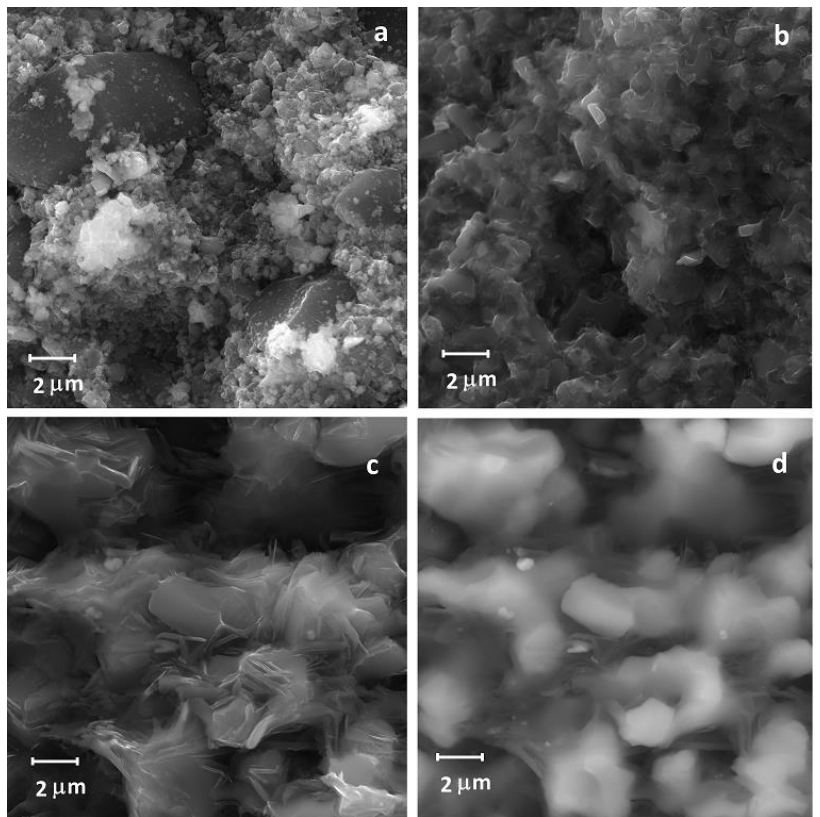
Figure 4. SEM images of the fracture surfaces of TiB 2 -BN-C samples. Hot pressing from TiN-B 4 C powder precursors at: ( a ) 1200 °С (secondary electrons), ( b ) 1650 °С, (secondary electrons), ( c ) 1900 °С (secondary electrons), ( d ) 1900 °С (back scattered electrons).